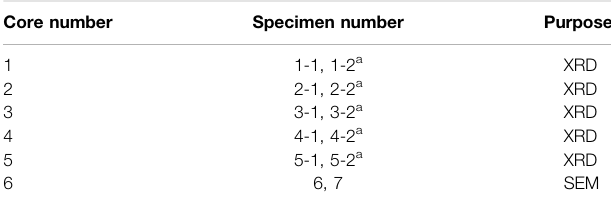
TABLE 2 | The corresponding relationship between core number and specimen